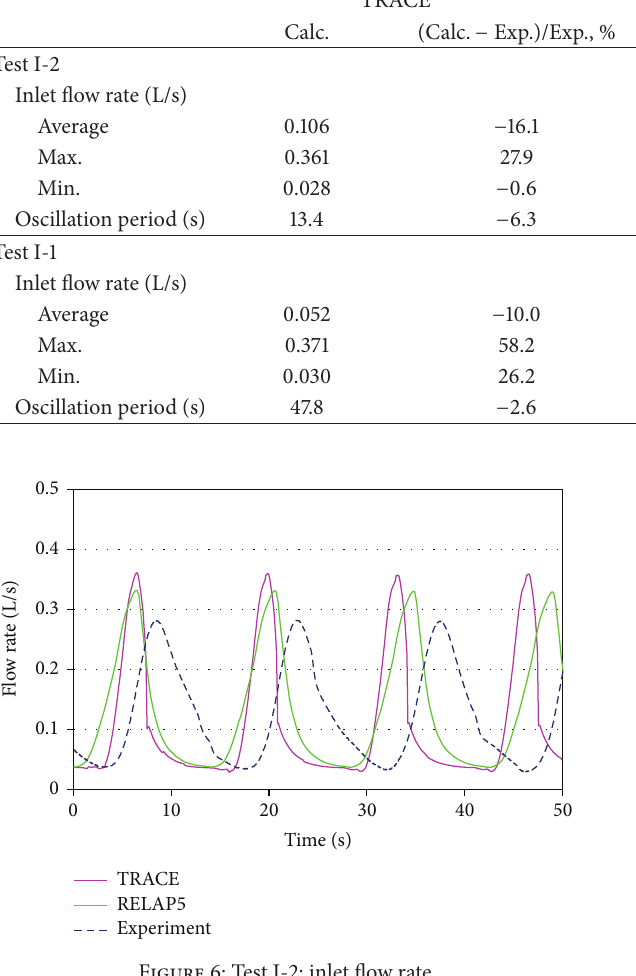
Figure 6: Test I-2: inlet flow rate.